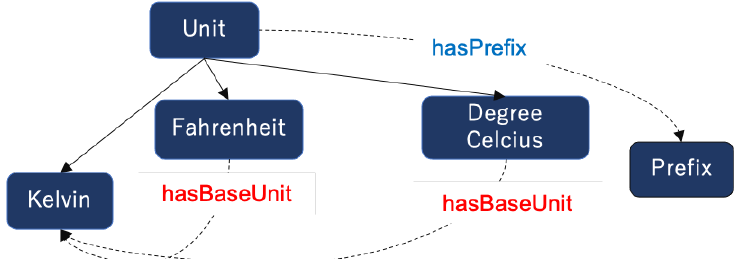
Figure 6. A part of subtree of unit